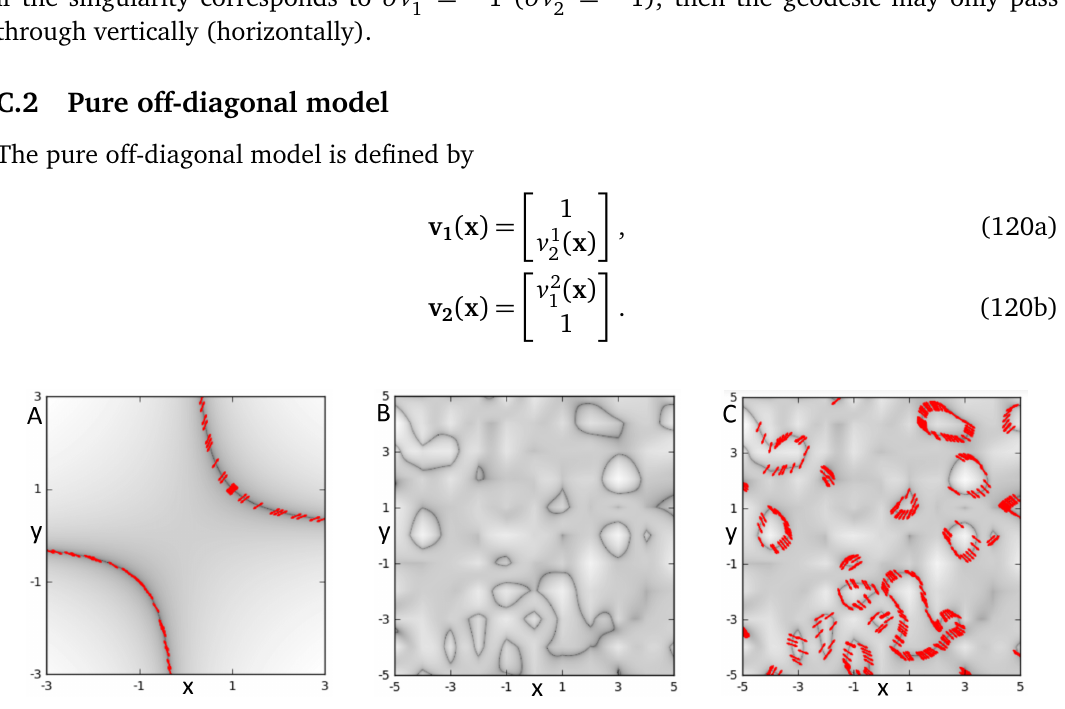
Figure 16: Curvature in the pure off-diagonal model. A: Heat map of time-dilation factor γ [ Eq. (121) ] for the “disorder space” off-diagonal manifold, with v = y . We note the singularities lie along the hyperbola { x y = 1 } . B: A heat map v 21 of time-dilation factor for a random realization of purely off-diagonal QGD. C: The heat map in B annotated to mark the collimation angles of the nematic singularities, which we note are clustered around ± π/